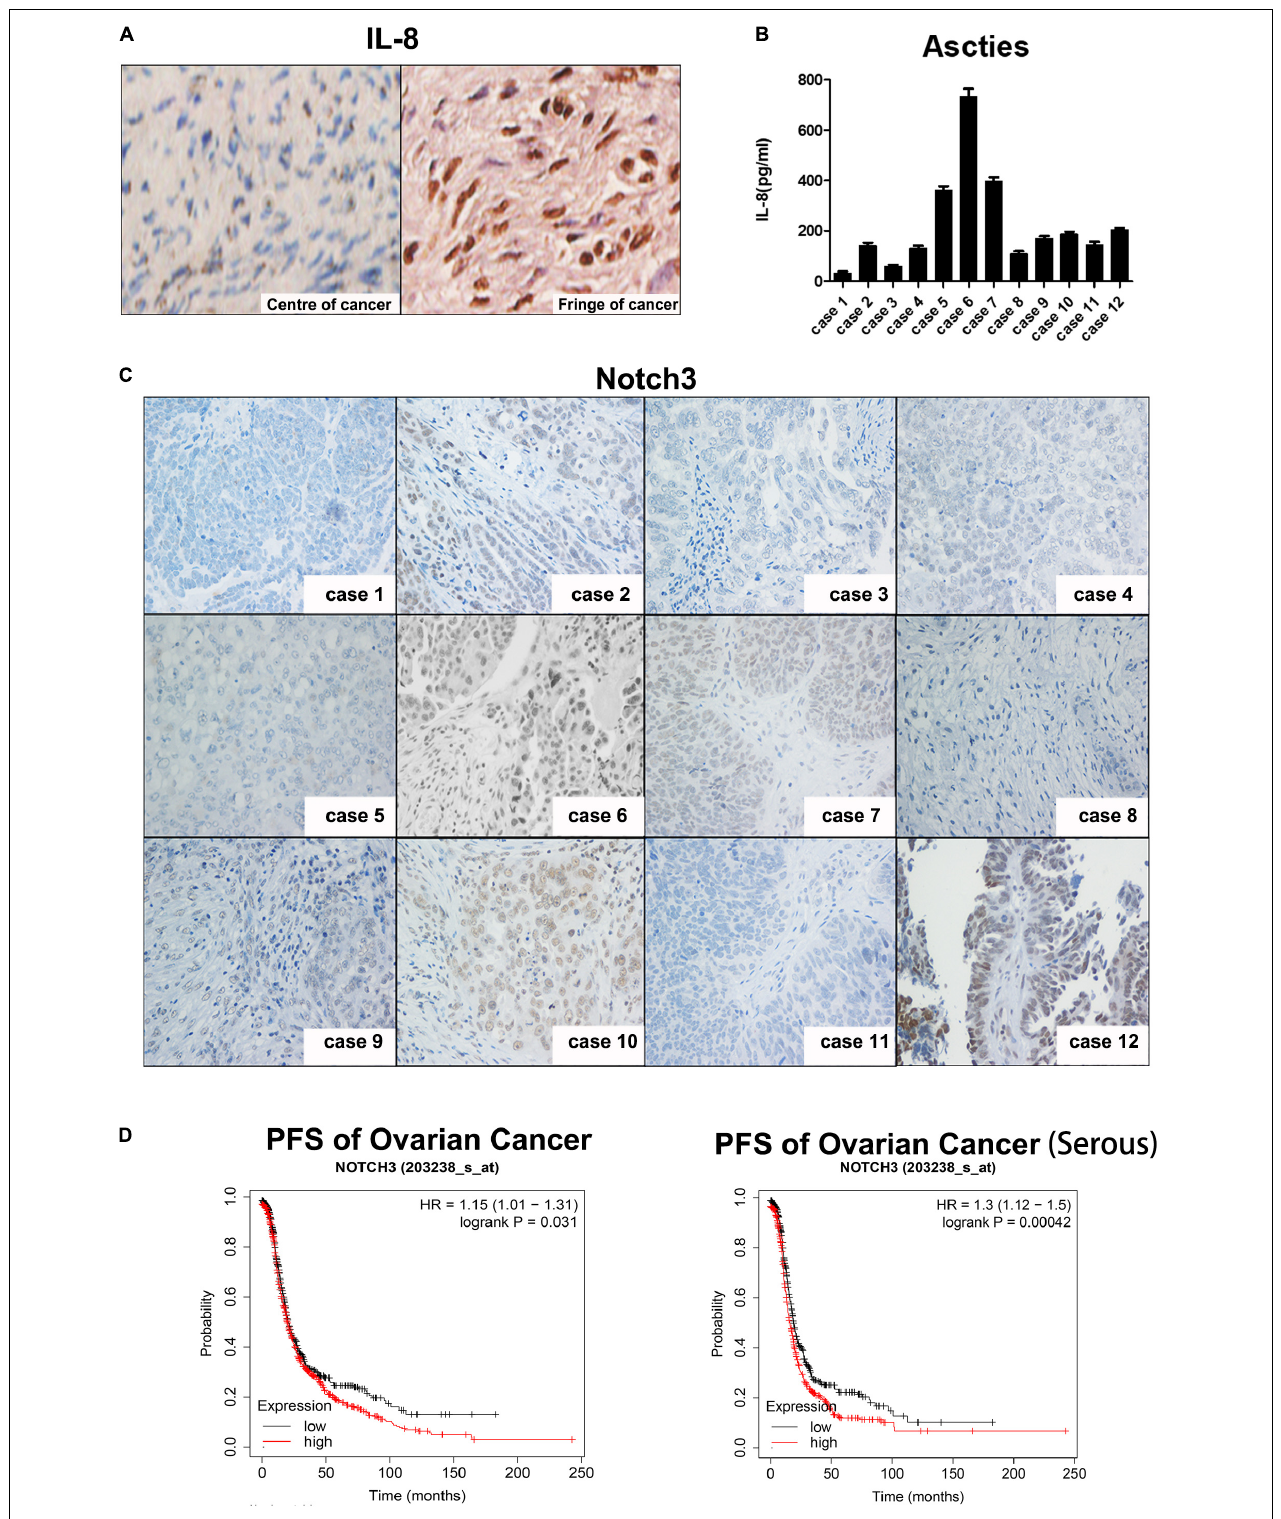
FIGURE 6 | Expression of IL-8 is associated with Notch3 in ovarian cancer tissues. (A) IHC staining of IL-8 expression in ovarian cancer tissues. Center (left) and fringe (right). Magnification, × 400. (B) IL-8 levels in ascitic fluid of 12 EOC patients were measured by ELISA. (C) Representative images showing Notch3 expression detected by IHC in ovarian cancer tissues. Magnification, × 200. (D) Prognostic analyses of ovarian cancer patients based on Notch3 mRNA levels calculated by the Kaplan–Meier survival curves (http://kmplot.com/analysis/index.php?p=service). IL, interleukin; IHC, immunohistochemistry; EOC, epithelial ovarian cancer.